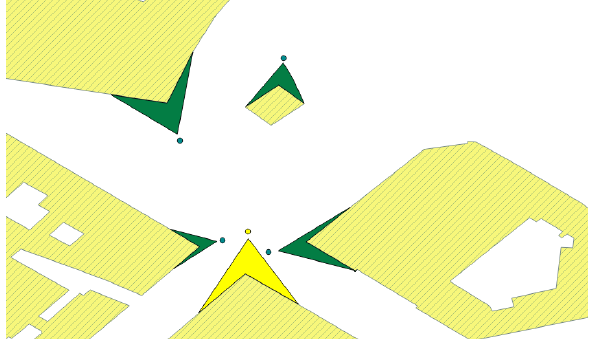
Figure 8. Map resulting from the GIS matching